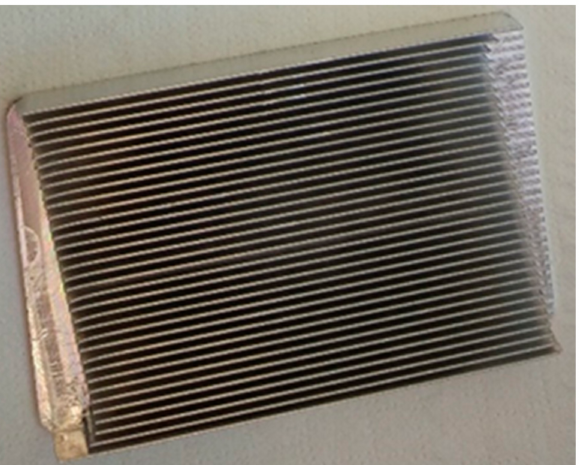
Figure 5. Example of affordable extruded finned heat sink SK624 from Fischer Elektronik [28], which has been adapted by the authors for liquid cooling by adding a cover and hoses and by machining inlet and outlet